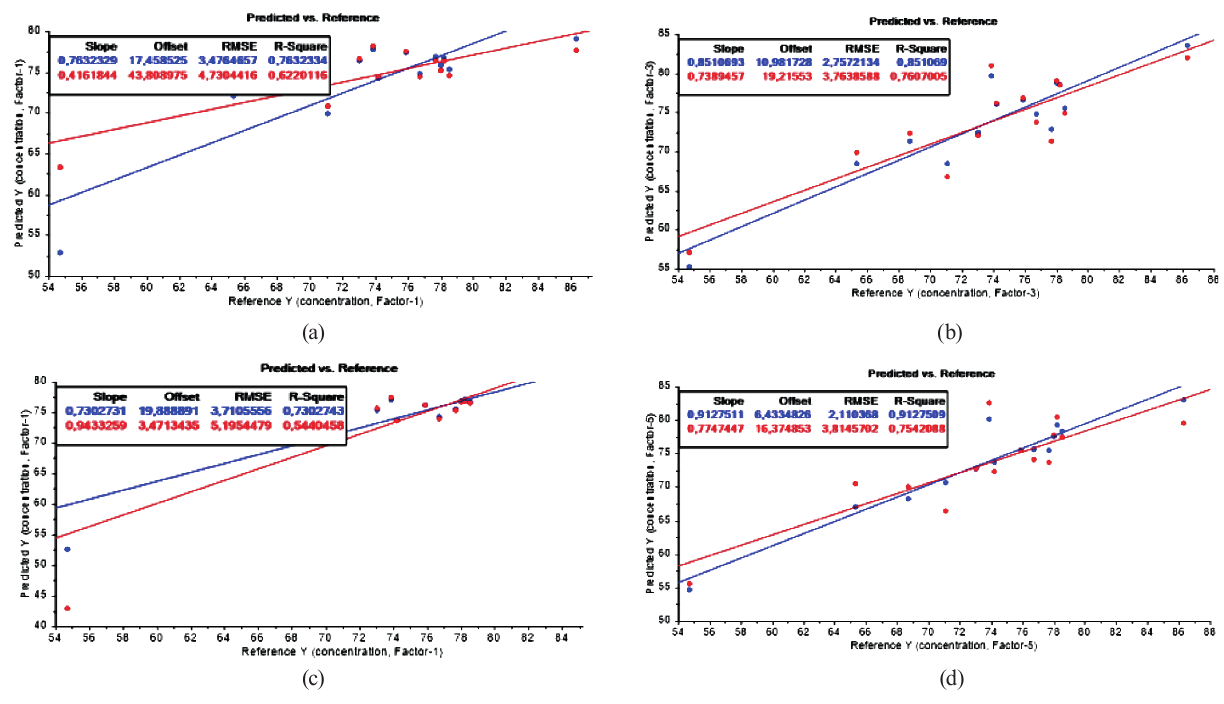
Figure 3 Predicted versus actual concentration of protein in whey supplements obtained by PLS calibration. (a) full FTIR spectrum; (b) sub-region: 1467–1600 cm –1 ; (c) full spectra after SNV normalization; (d) sub-region: 1160–2205 cm –1 after SNV normalization